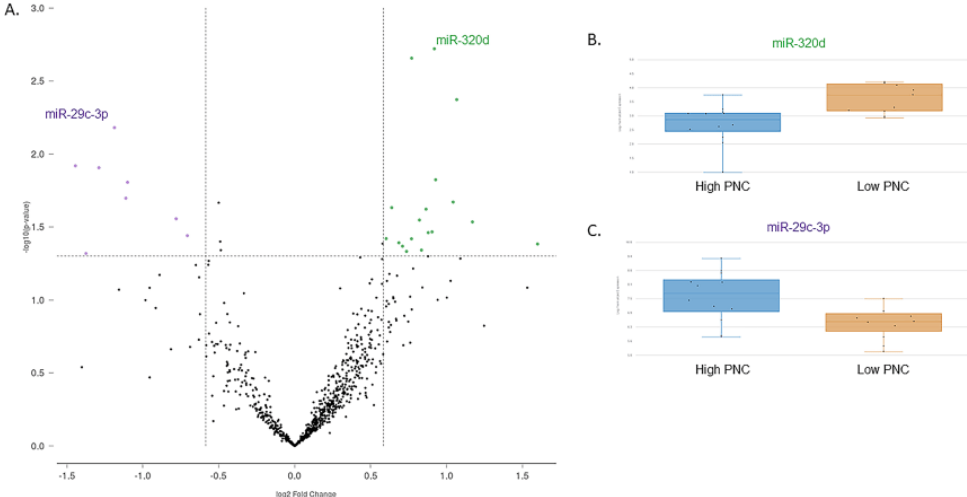
Figure 4. miRNA differential expression data in low versus high PNC: ( A ) volcano plot comparison of EWS tumors (n = 23) with high (n = 12) or low (n = 11) PNC was generated ( A ), and miRNA transcripts with a preset threshold of log2FC of 1.5 is seen on the x -axis of the volcano plot, and the negative log of p -value are shown on the y -axis, with a preset threshold of p < 0.05. A total of 26 miRNA transcripts were identified within these parameters, 18 miRNA transcripts were decreased (colored in green) in tumors with high PNC prevalence, and 8 were increased (colored in purple). Two transcripts with the most significant p -values include that of miR-320d ( B ) and miR-29c-3p ( C ), which also showed the most significant fold change in high PNC tumors.